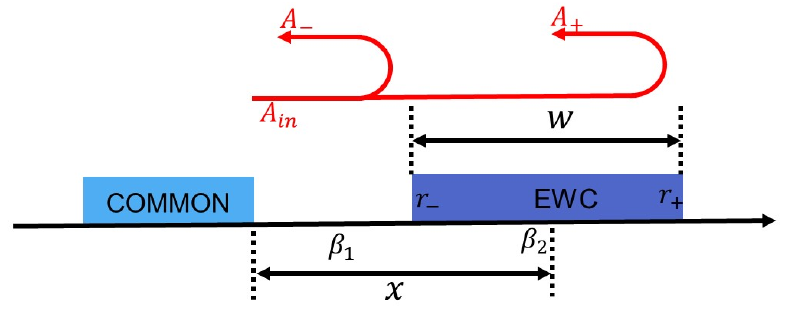
Figure 5. The reflection of t he EWC electrode.